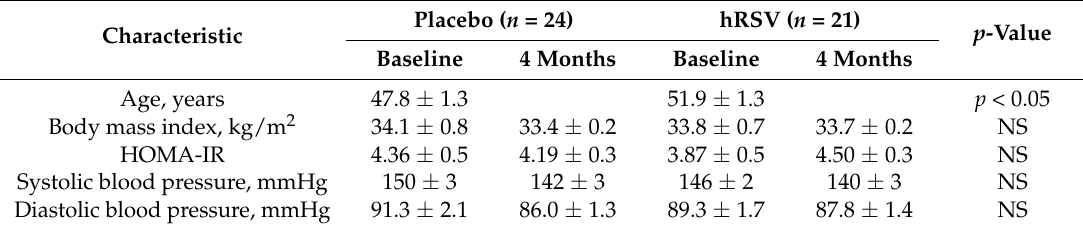
Table 1. Clinical features at baseline and post-treatment.